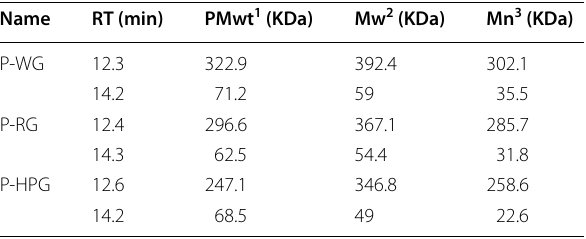
1 The peak molecular weight 2